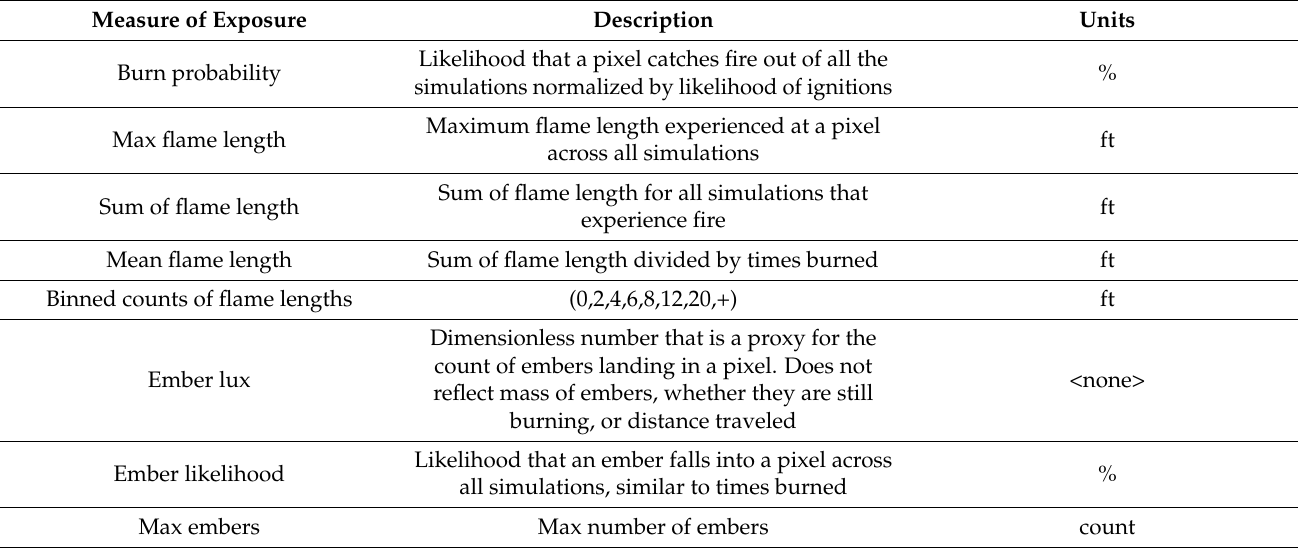
Table 2. Hazards quantified by the FSF-WFM: following the ELMFIRE simulations for 2022 and 2052, the wildfire hazard for any 30 m pixel within the CONUS domain is represented by the combination of the burn probability, mean or maximum flame length (intensity), and exposure to